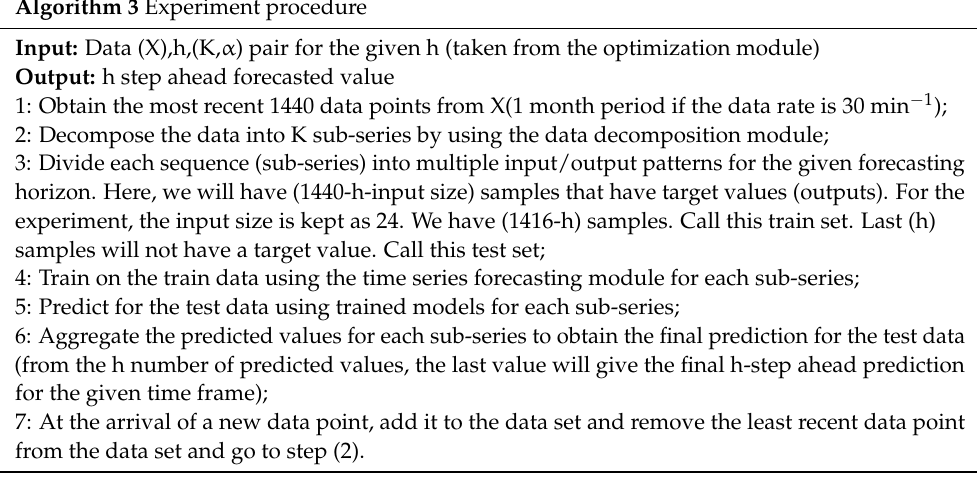
Algorithm 3 Experiment